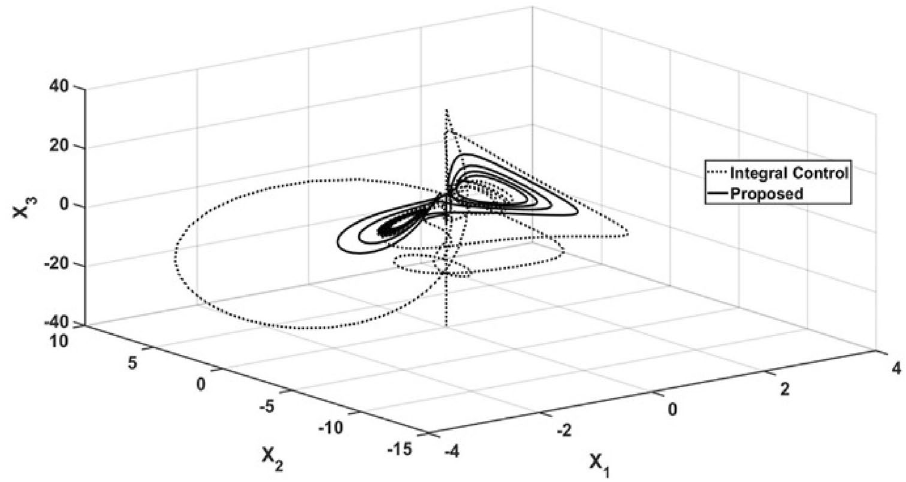
Figure 10. Phase portrait of the tracking trajectory.